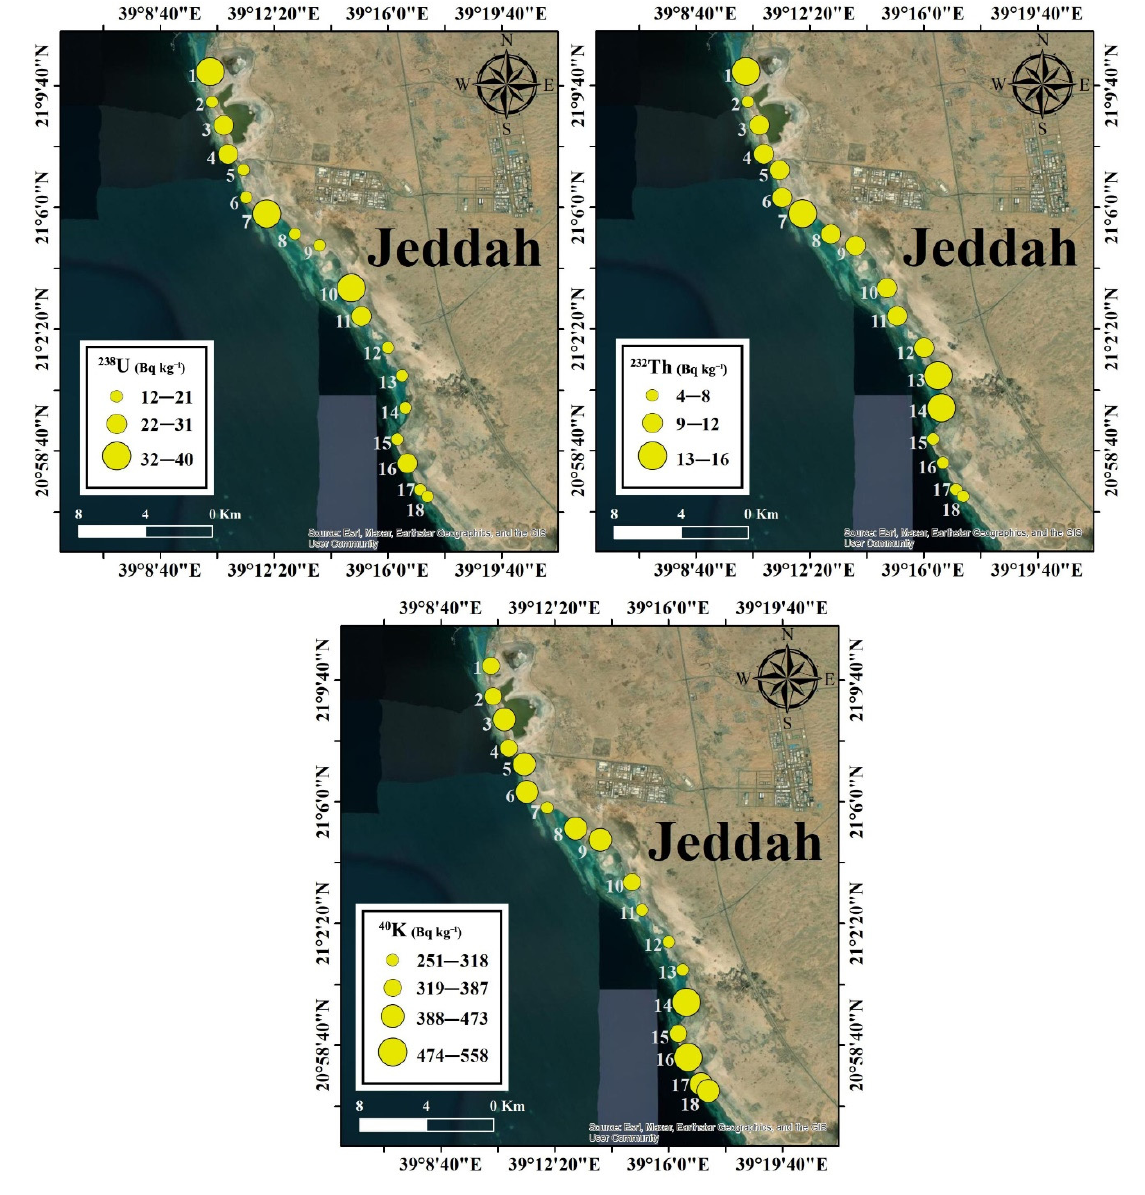
Figure 5. Distribution pattern maps of 238 U, 232 Th, and 40 K activity concentrations.